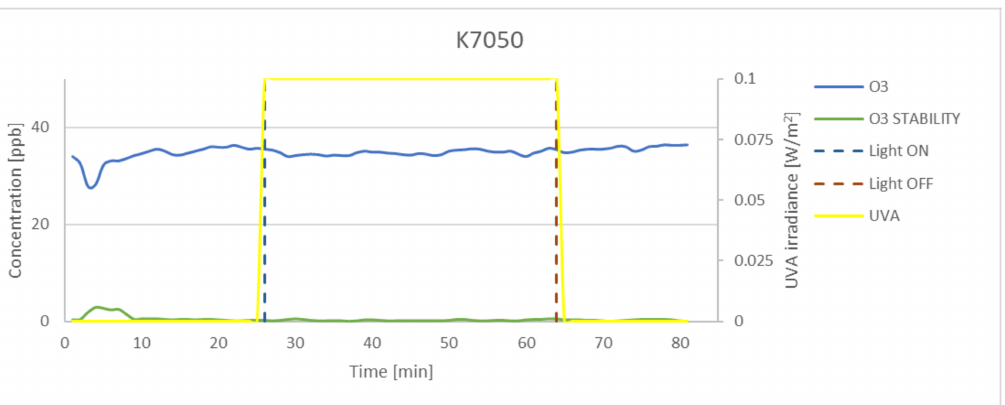
Figure 10. The oxidation of O 3 in the photocatalytic reaction with concentrations measured for K7050. Data on UVA irradiation are shown in the supplementary chart. Dashed lines indicate the time of light on and off.